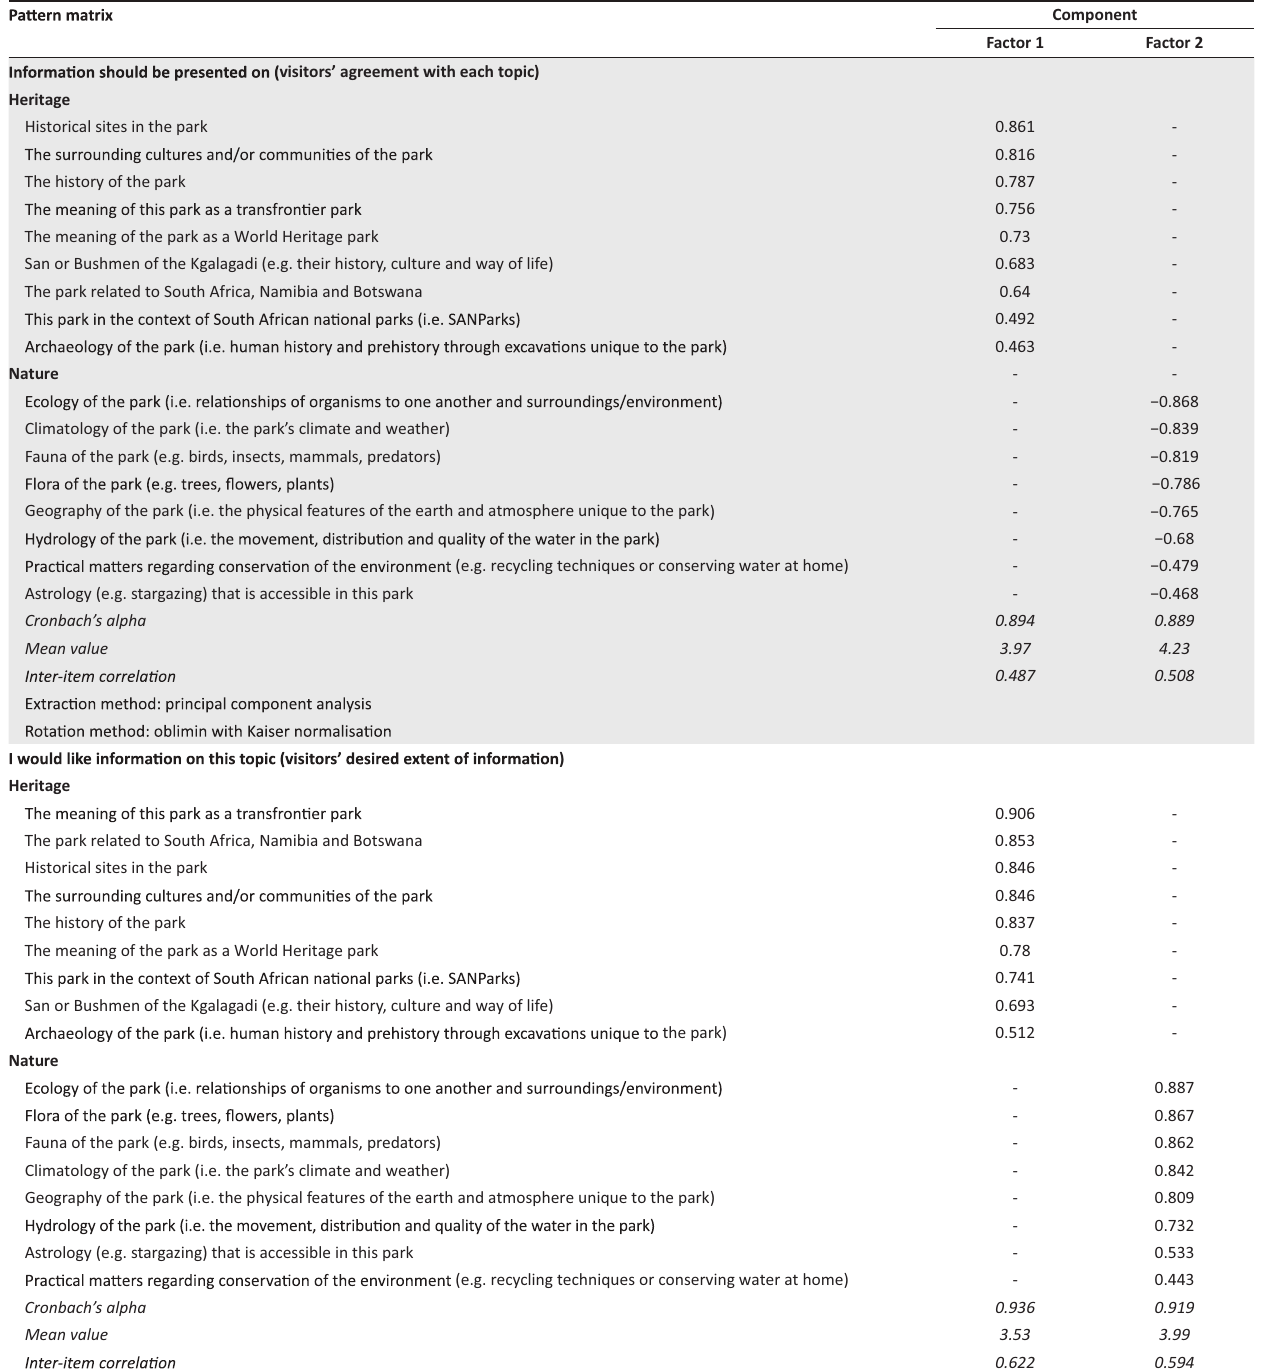
FIGURE 3: Desired topics and extent of information in the interpretation